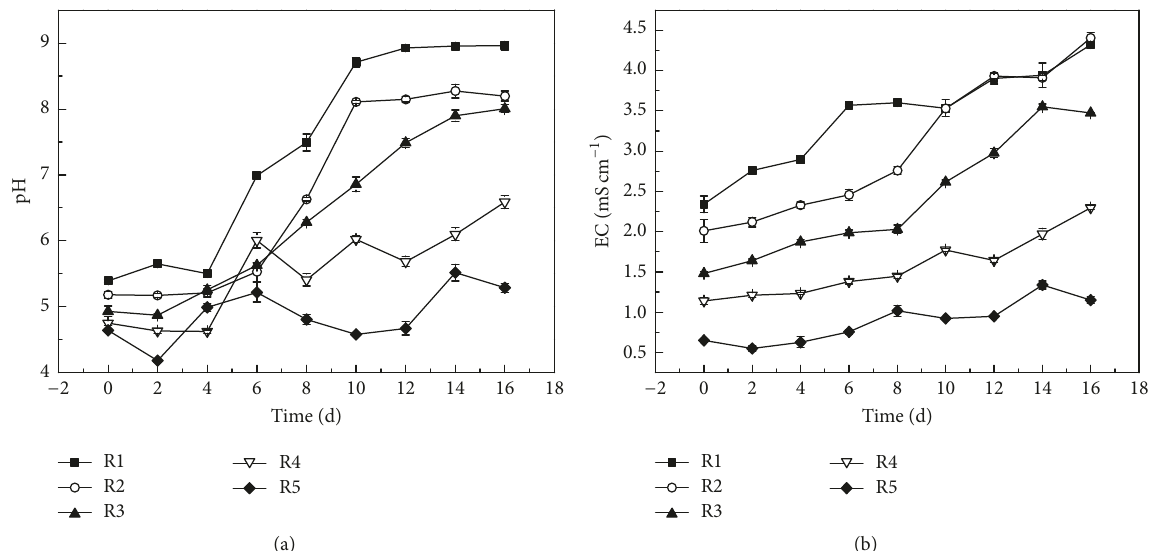
Figure 6: (a) pH for the composting of KW and (b) EC for the composting of